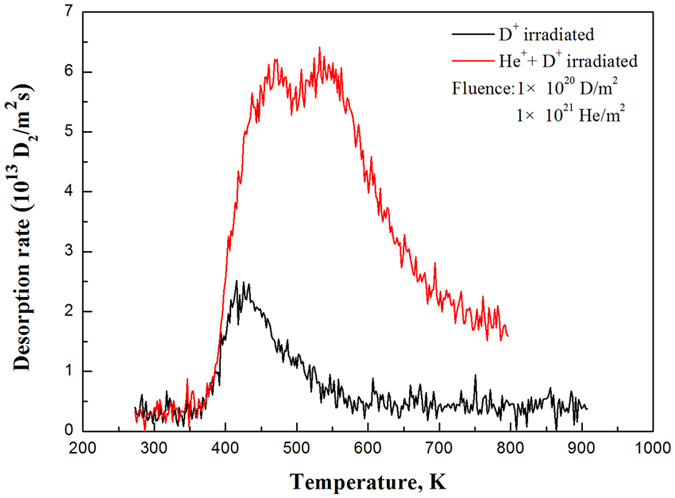
TDS spectra of helium for the W-5%Lu and W-5%Lu samples pre-irradiated with 5 keV He+ ions to a fluence of 1 × 1021 He/m2.